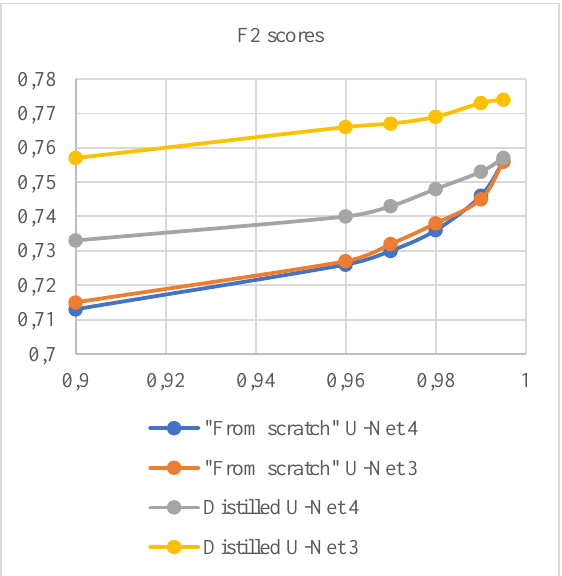
Figure 4. Comparison of performances between networks learned from scratch and distilled networks in function of the binarization